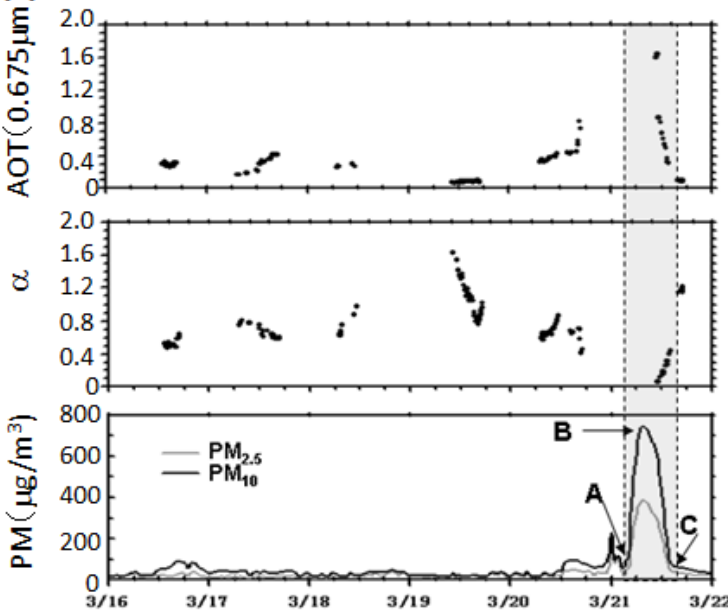
Figure 2. Ground measurements of atmospheric particles in March 2010, where the upper, middle and bottom panels represent the AOT at 0.675 m, α measure with (aerosol robotics network (AERONET) and the PM measured with the suspended particulate matter (SPM) sampler, respectively. A, B and C denote the values before, at the peak of and after the dust event, respectively.